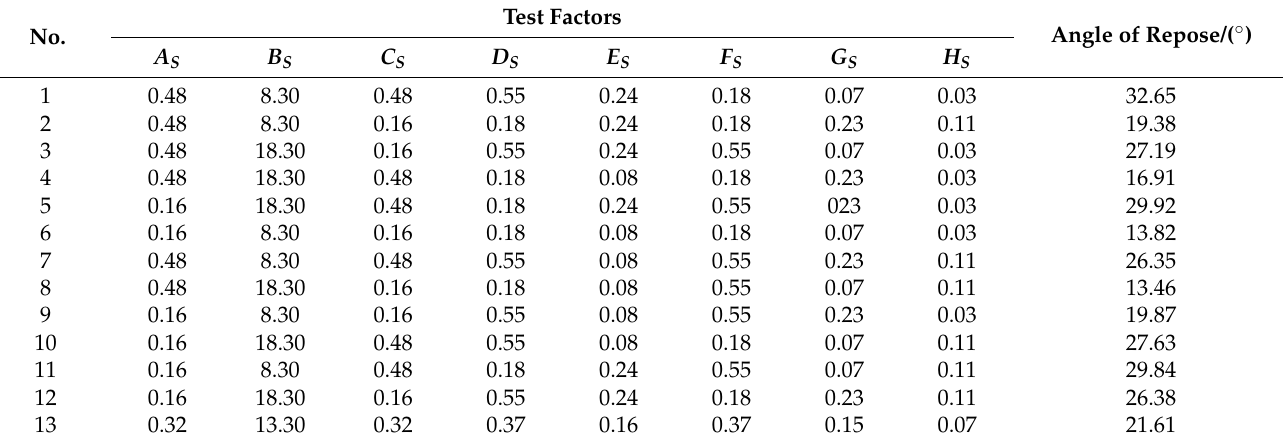
Table 6. Plackett–Burman test protocol and